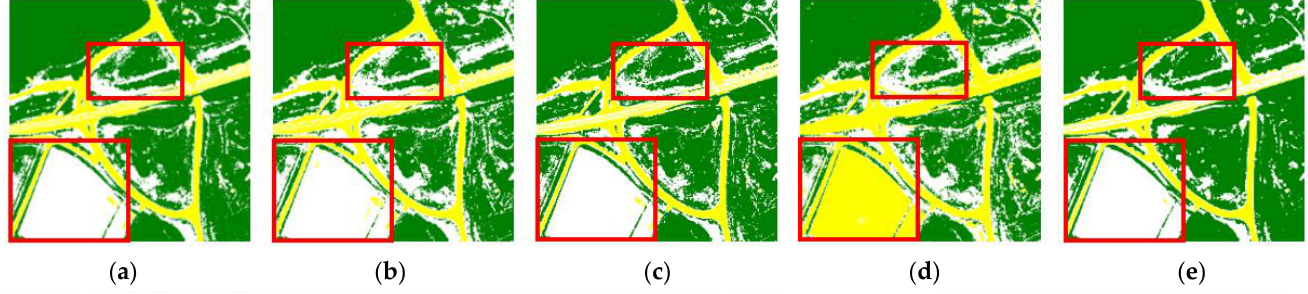
( o ) Figure 5. Experiment results of S2 images. The red rectangle boxes are selected as the comparison areas. ( a ) S2 K-means, ( b ) S2 ISODATA, ( c ) S2 FCM, ( d ) S2 IFCM, ( e ) S2 FLICM, ( f ) S2 HMRF-FCM, ( g ) S2 FCM_S, ( h ) S2 FCM-SICM, ( i ) S2 SFFCM, ( j ) S2 FRFCM, ( k ) S2 SPFCM, ( l ) S2 SBPNN, ( m ) S2 FBPNN, ( n ) S2 SOM, and ( o ) S2 SSIFCM. Table 6. Evaluation of S2 image classification results. S2